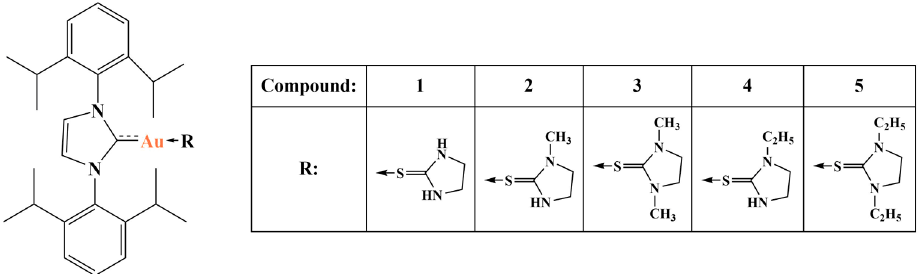
Figure 27. The complexes presented in [105].